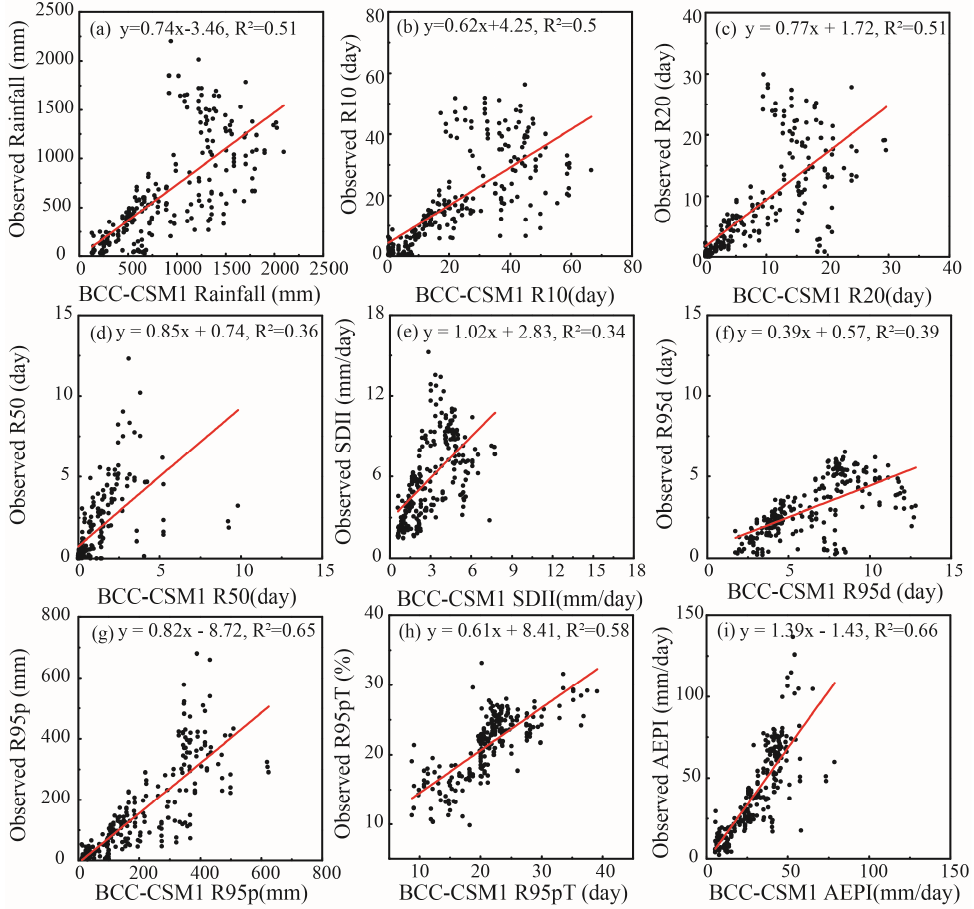
Figure A3. Scatterplot of the annual extreme precipitation indices calculated with CMA data and BCC-ESM 1-1 data: ( a ) scatterplot of rainfall, ( b ) scatterplot of R10, ( c ) scatterplot of R20, ( d ) scatterplot of R50, ( e ) scatterplot of SDII, ( f ) scatterplot of R95d, ( g ) scatterplot of R95p, ( h ) scatterplot of R95pT, and ( i ) scatterplot of in AEPI. Table A1. The Pearson correlation coefficients for extreme precipitation indices between CMIP5 models and CMA observations.